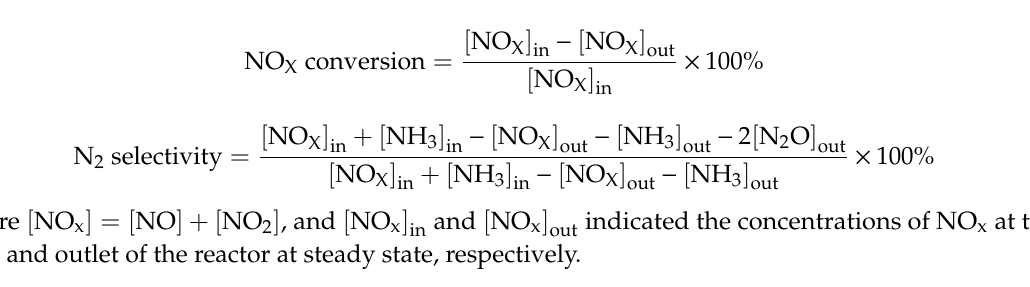
Figure S1: TGA under air (5 ◦ C / min heated rate) of xCeO 2 / quasi-MIL-101, Figure S2: The di ff raction peak of MIL-101(Cr) and MIL-101(Cr) samples of the published literature, Figure S3: Nitrogen adsorption-desorption isotherms of MIL-101(Cr), quasi-MIL-101(Cr) and xCeO 2 / quasi-MIL samples, Figure S4: The SEM image of the MIL-101(Cr), Figure S5: (a) TEM image of 0.4% CeO 2 / quasi-MIL-101 (b) TEM image of 0.5% CeO 2 / quasi-MIL-101 (c) TEM image of 0.6% CeO 2 /